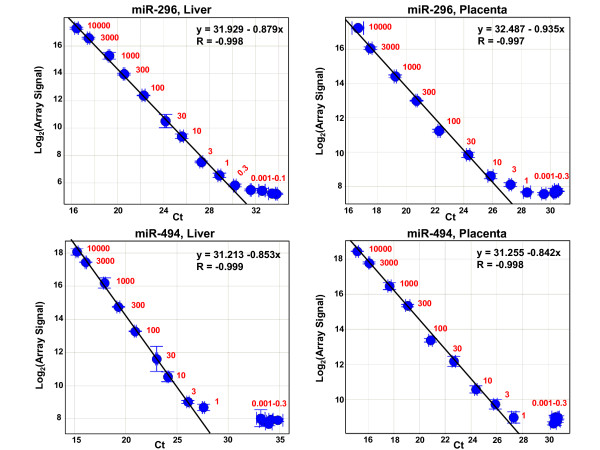
Comparison of qPCR and microarray measurements for miR-296 and miR-494 titrations. Scatter plots are shown for titration of synthetic miR-296 into liver (top left panel) and placenta (top right panel) total RNAs, and miR-494 into liver (lower left) and placenta (lower right) total RNAs. Ct values from qPCR are plotted on the x-axis, while log2 of the total gene signal from microarray measurements are plotted on the y-axis. Numbers in red show the number of attomoles of spike-in miRNA per 100 ng total RNA. Equations and R values are for the orthogonal line fit of the linear regions of each titration. Error bars indicate standard deviation (SD) of Ct values for qPCR results and (SD/Mean)*log2e for the array results.